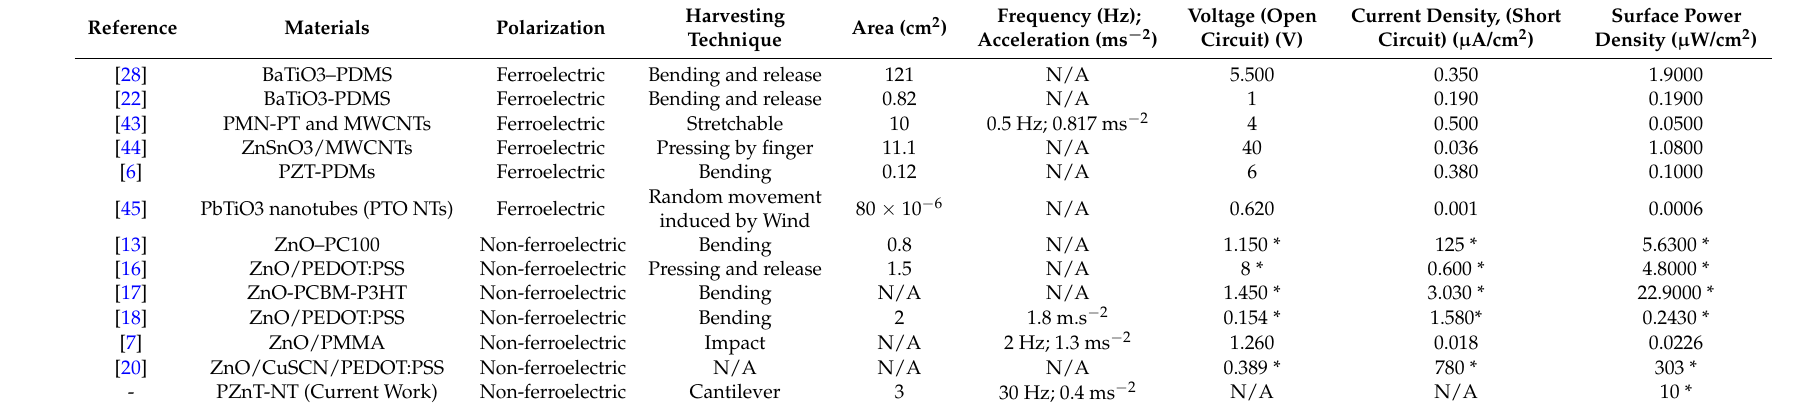
Table 3. Comparison of the surface power density for numerous